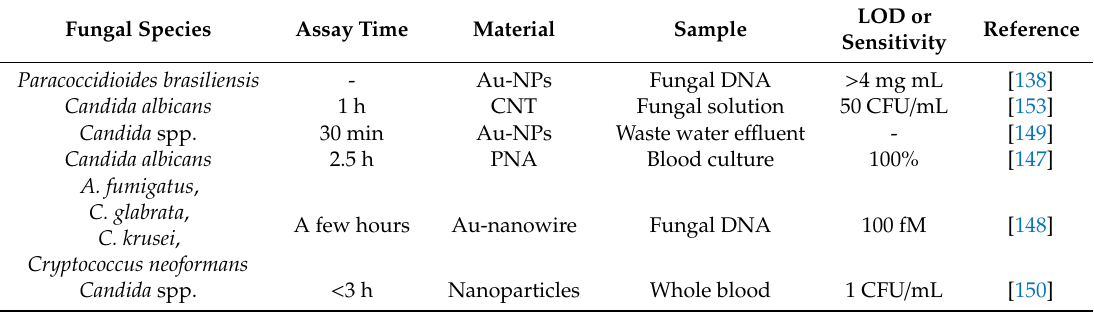
Table 2. Assays reported for fungal detection based on nanoengineered